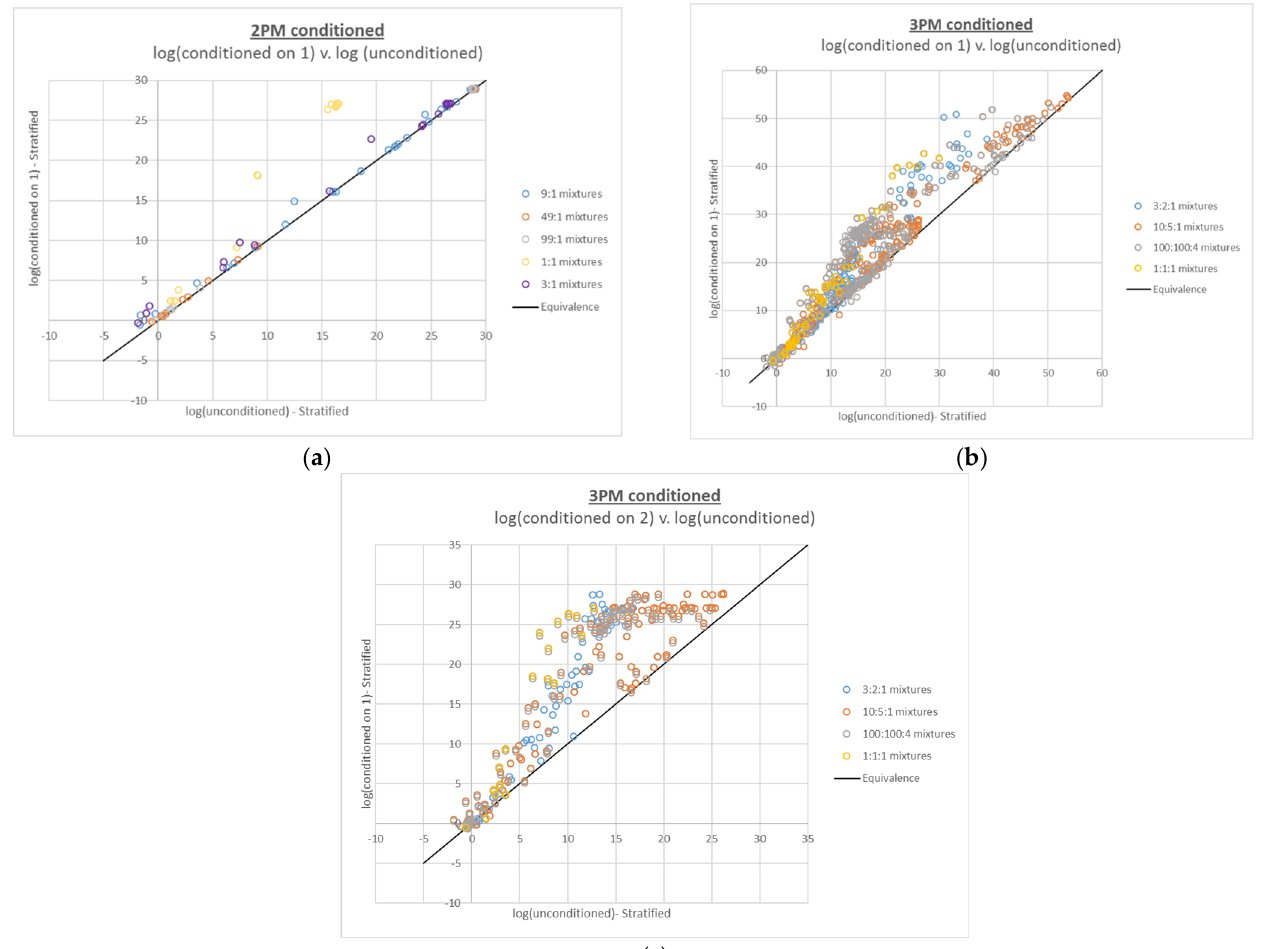
Figure 2. Plots of 2- and 3-person log(LR)s based on conditioned interpretations v. corresponding log(LR)s based on unconditioned interpretations: ( a ) 2-person mixtures conditioned on 1 true contributor, ( b ) 3-person mixtures conditioned on 1 true contributor, and ( c ) 3-person mixtures conditioned on 2 true contributors.